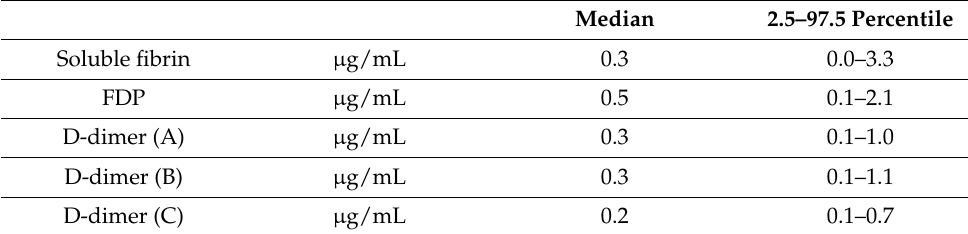
Table 1. D-dimer, soluble fibrin, and FDP in healthy